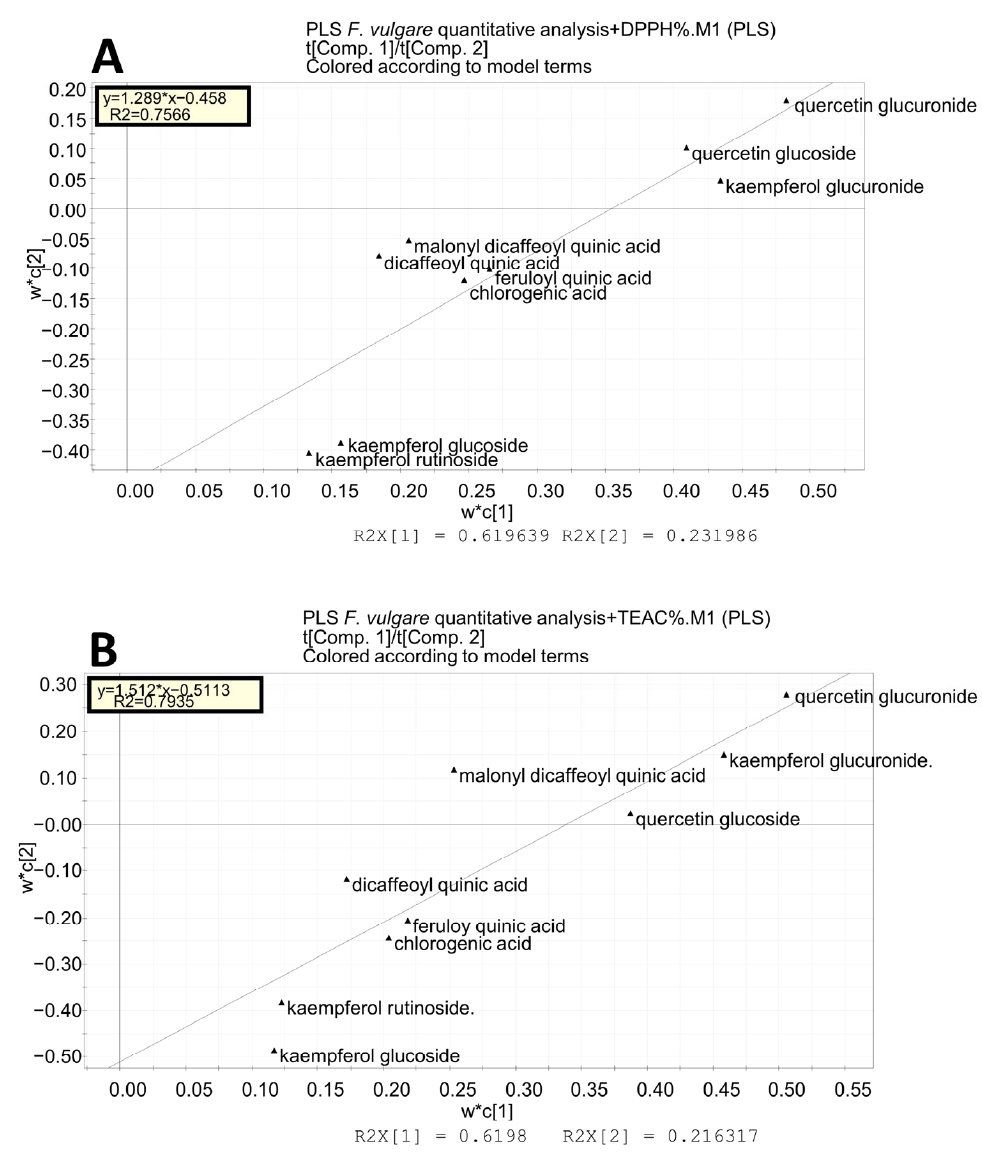
Figure 4. Partial least square analysis: loading scatter plots obtained from a targeted data analysis excluding the outlier isorhamnetin glucuronide. ( A ) Loading scatter plot with regression line with the Y-block as the DPPH value; ( B ) loading scatter plot with regression line with the Y-block as the TEAC value.